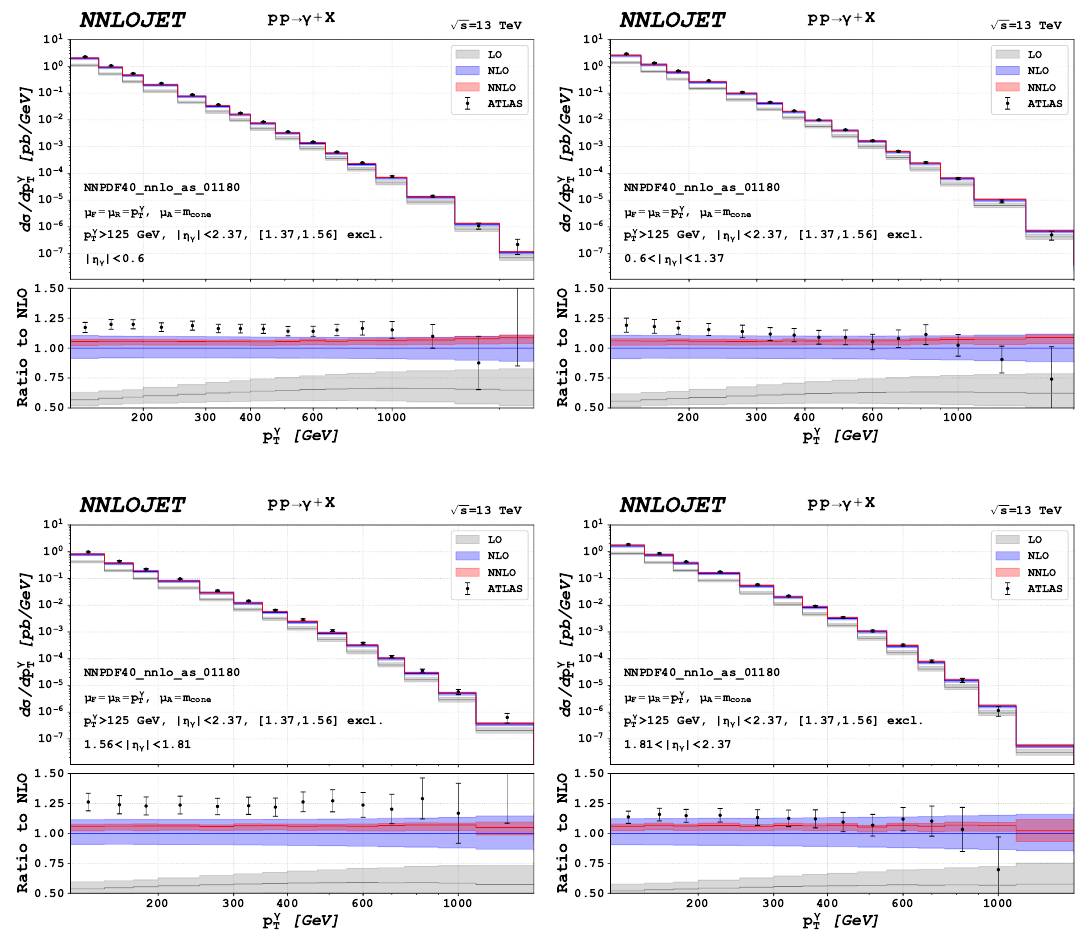
Figure 1. Photon transverse momentum distributions for isolated photon production at LO, NLO and NNLO for four different pseudorapidity bins. The prediction are compared to 13 TeV ATLAS data